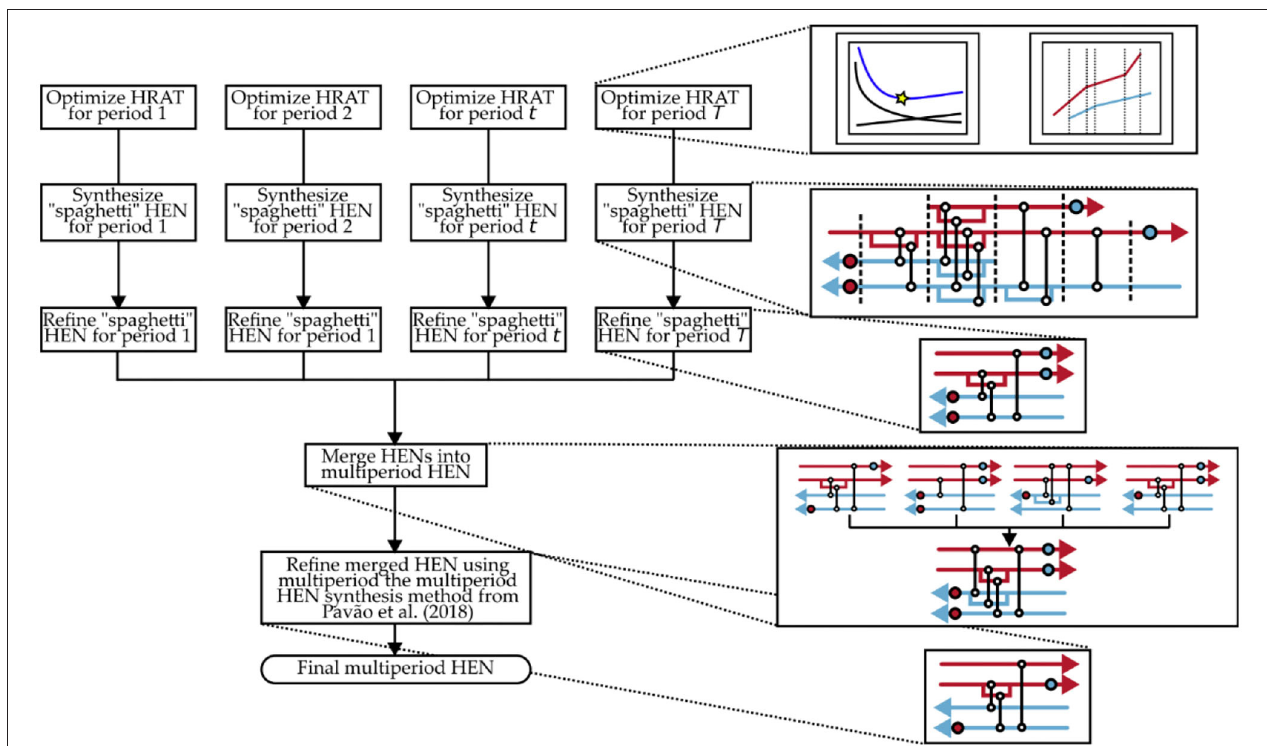
FIGURE 1 | Methodology flow